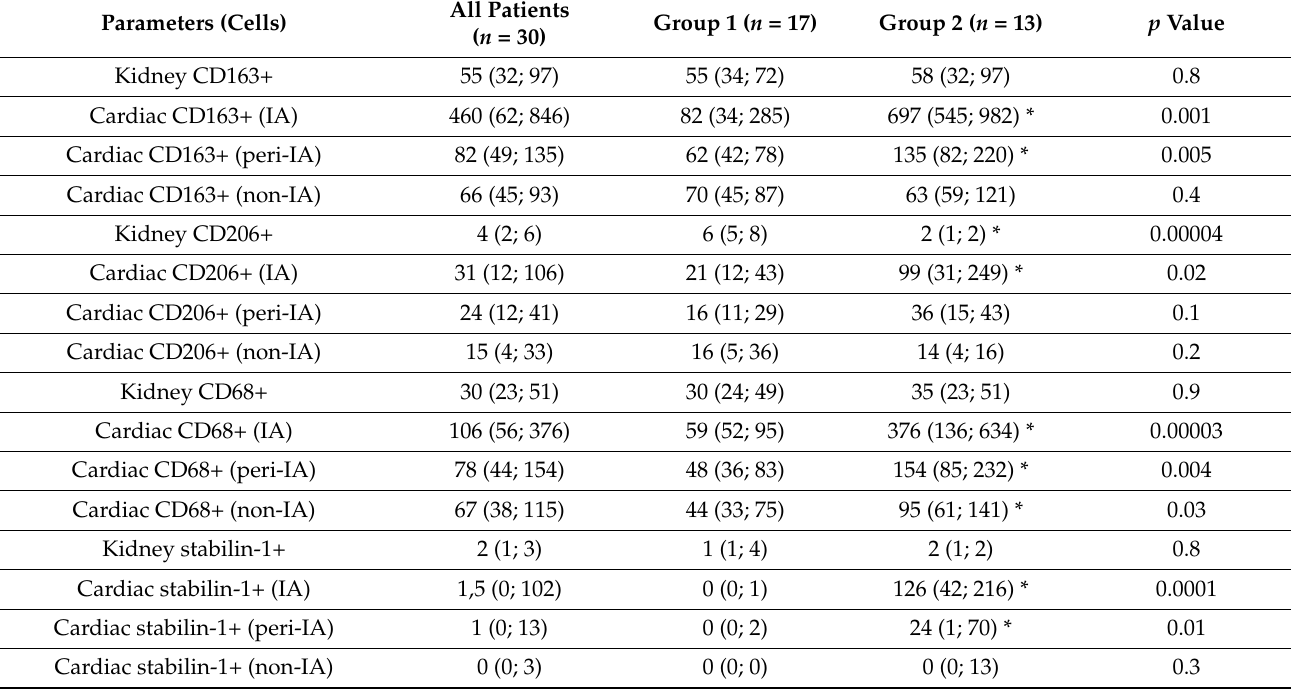
Table 2. Dynamics of cardiac and kidney macrophages in patients ( n = 30) with fatal MI, depending on the period of MI.